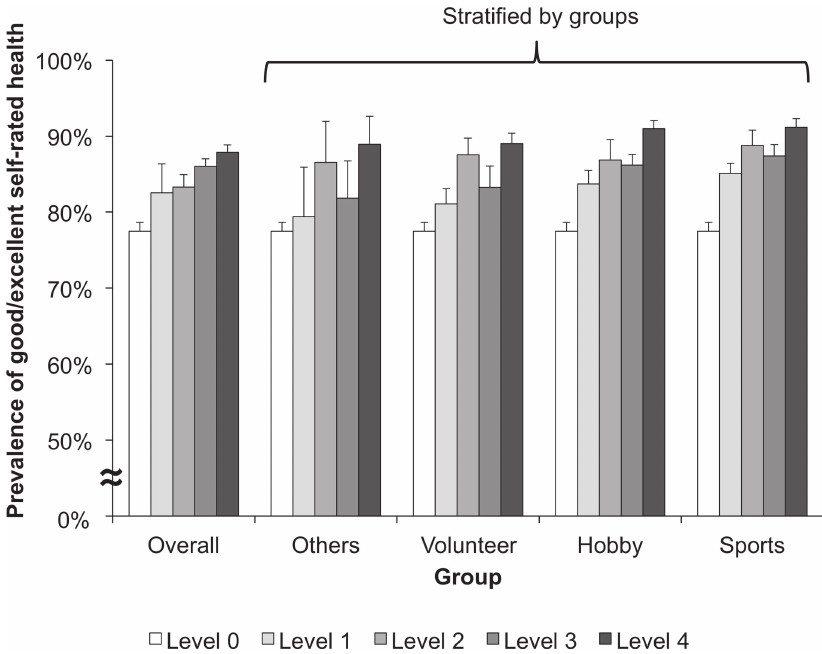
Figure 1. Prevalence of good / excellent self-rated health for each diversity level of group membership. Each bar chart and error bar shows a combined prevalence and 95% con fi dence interval of good / excellent self-rated health estimated by multiple imputation. We assessed the diversity level of group membership based on three dimensions of diversity (gender, residential area, and age composition). The diversity level was graded into as follows: level 0 (not involved in any groups), level 1 (involved in a group; none of the three dimensions was diverse), level 2 (involved in a group; one of the three dimensions was diverse), level 3 (involved in a group; two of the three dimensions were diverse), or level 4 (involved in a group; all dimensions were